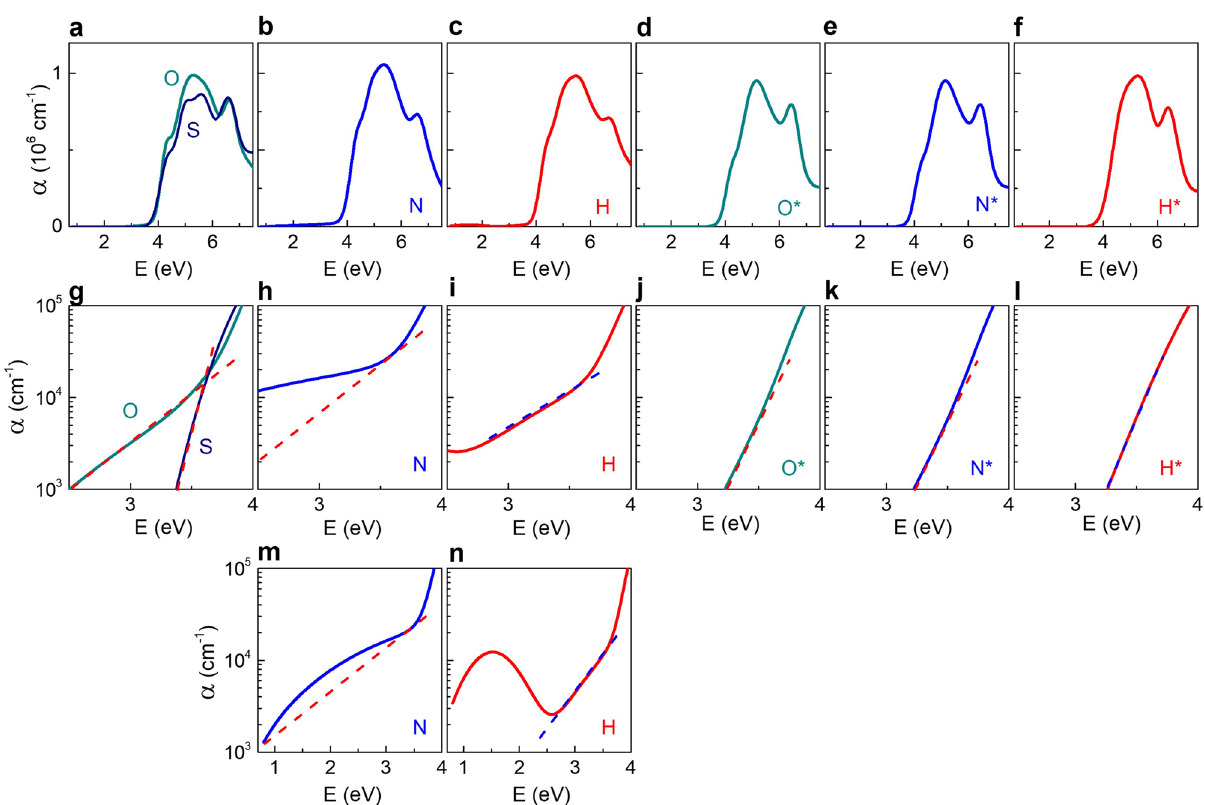
Figure 3. Absorption coefficient α as a function of photon energy. Spectral range is ( a – f ) from 0.7 to 7.5 eV, ( g – l ) from 2.5 to 4.0 eV, and ( m , n ) from 0.7 to 4.0 eV. Dashed lines show Urbach absorption in ( g – n ). STO films are marked as follows: S epitaxial stoichiometric, O epitaxial with oxygen vacancies, N epitaxial with nitrogen substitution, H epitaxial with hydrogen substitution, O* polycrystalline with oxygen vacancies, N* polycrystalline with nitrogen substitution, H* polycrystalline with hydrogen